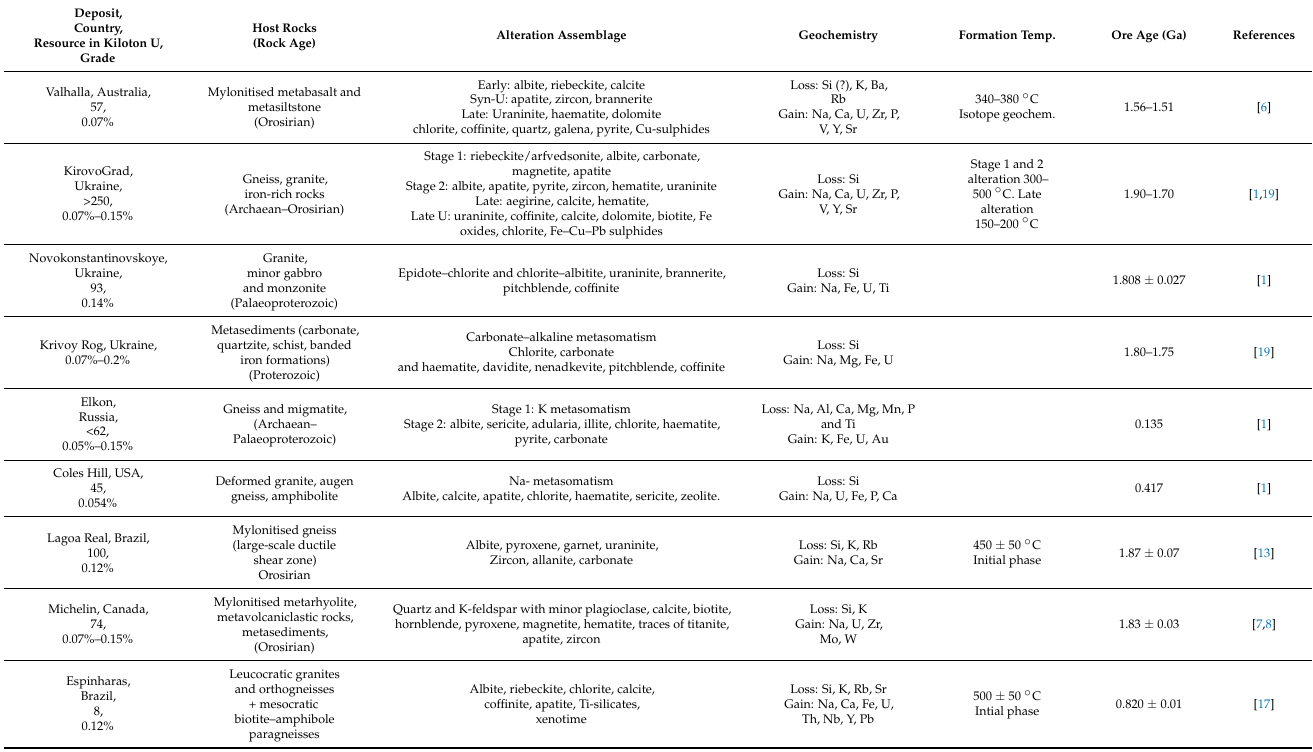
Table 1. Summary of world metasomatite uranium